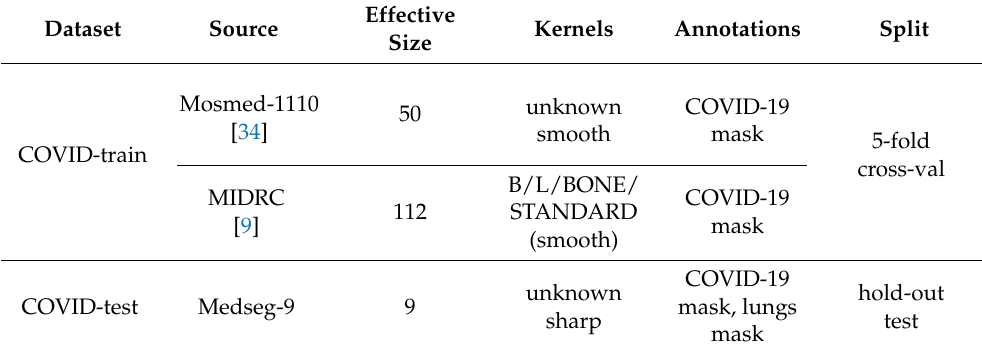
Table 1. Summary of the segmentation datasets. Effective size means the number of annotated images after appropriate